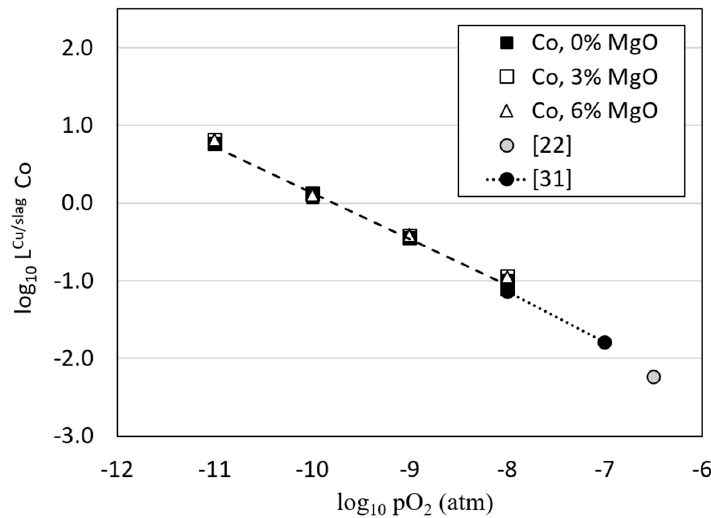
Figure 8. The distribution coefficient of cobalt between copper alloy and molten slag. Results from two earlier studies are plotted for comparison.